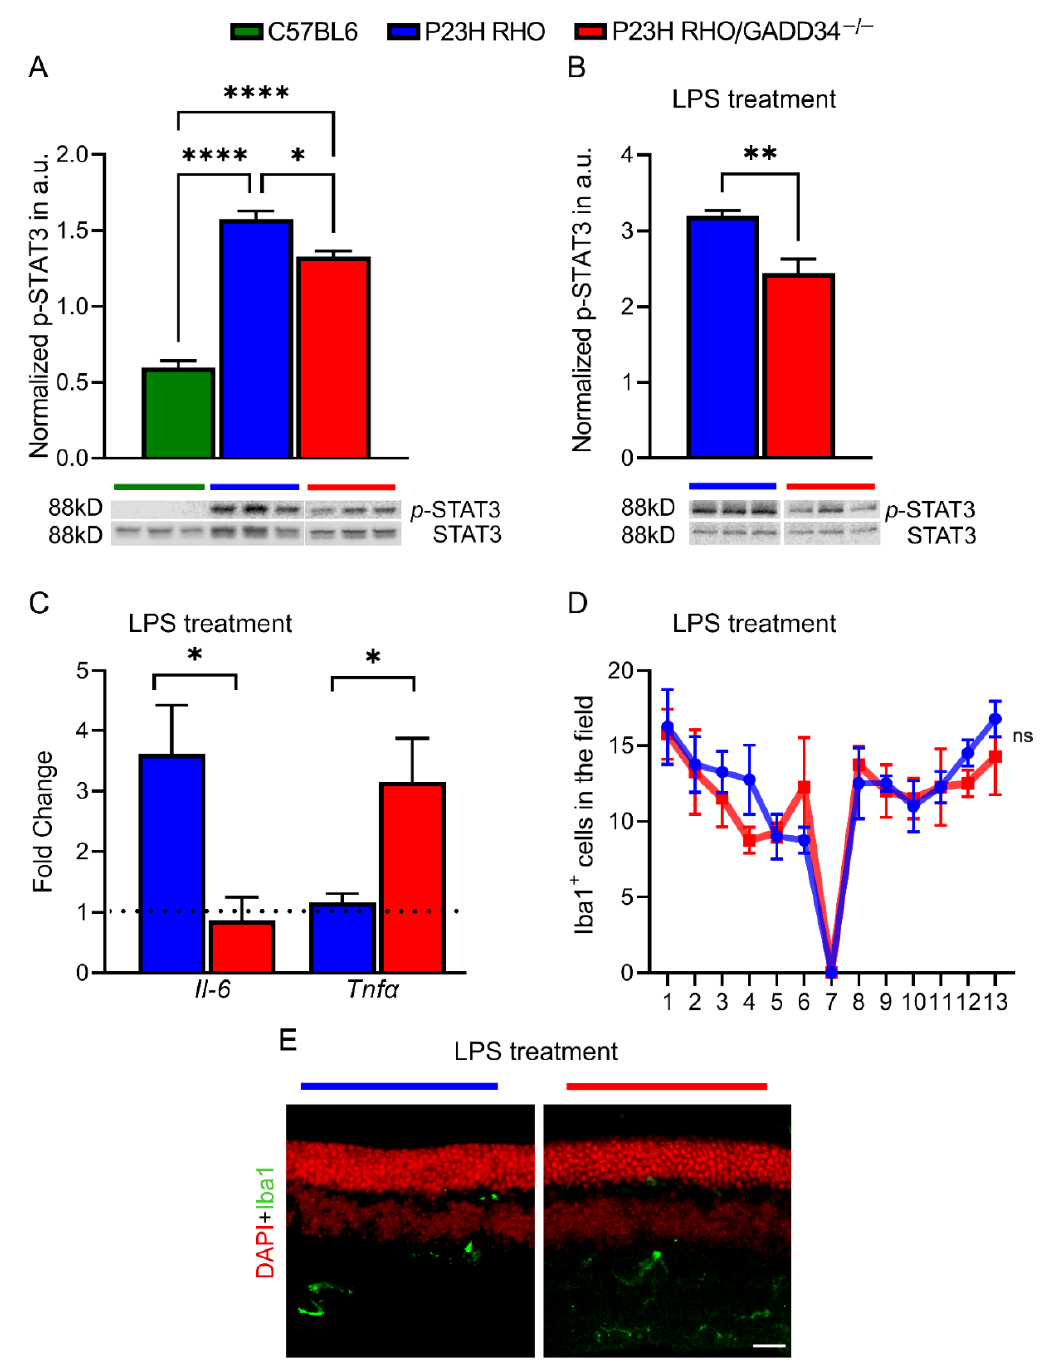
Figure 3. GADD34 controls STAT3 activation and cytokine expression in P23H RHO retinas. ( A ) The level of activated STAT3 (Y705) was significantly elevated in naïve P23H RHO retinas at P30 compared to C57BL6 mice with GADD34 ablation in these animals, resulting in a decline in the level of p-STAT3 ( n = 4). Images of Western blots probed with anti-p-STAT3 and STAT3 antibodies are shown. Relative density measurements correspond to the intensities of the immunoblotting bands normalized to the STAT3 control. ( B ) The treatment with LPS revealed a difference in the p-STAT3 level between the two groups of degenerating mice in 6 h. Western blot images are also shown. ( C ) The decline in p-STAT3 in the P23H RHO GADD34 − / − retinas was accompanied by a decrease in Il-6 and an increase in Tnfa expression in 24 h with LPS treatment ( n = 5). ( D ) Interestingly, despite the cytokine and STAT3 regulation by GADD34, the number of macrophages and microglia in the retinas of the LPS-administered mouse groups did not change. ( E ) Images of LPS-treated mice retinas stained with anti-Iba1 antibody. The scale bar is 20 µm. * p < 0.05, ** p < 0.01, and *** * p < 0.0001, “ns”—not significant.